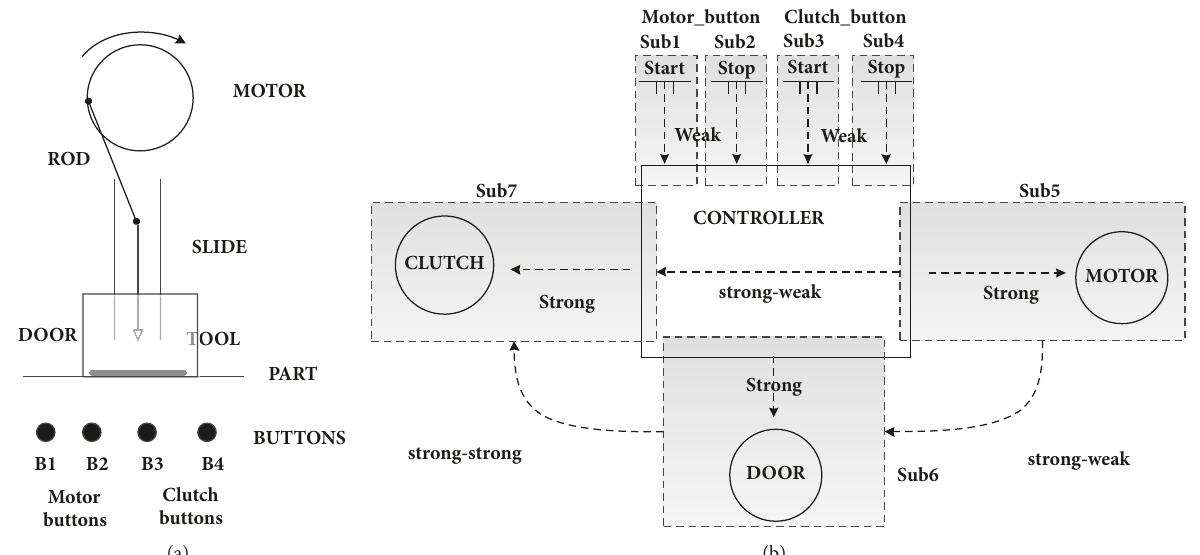
Figure 14: Mechanical press controller